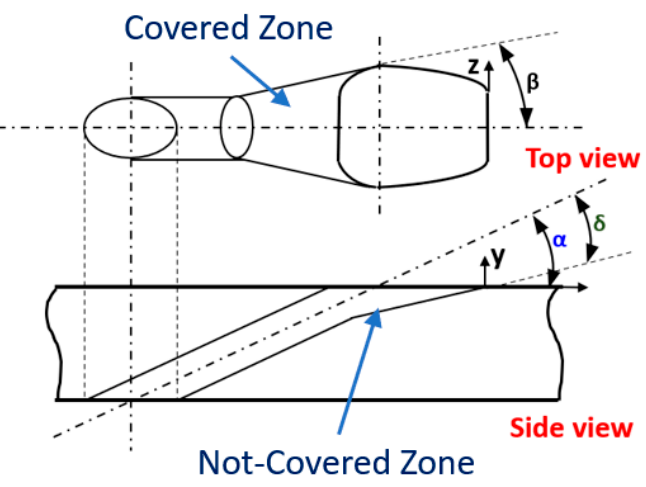
Figure 6. Patent publications show internal knowledge in the gas turbine industry that film hood has a significant influence on the attachment and stability of the cooling film [22,33,34].